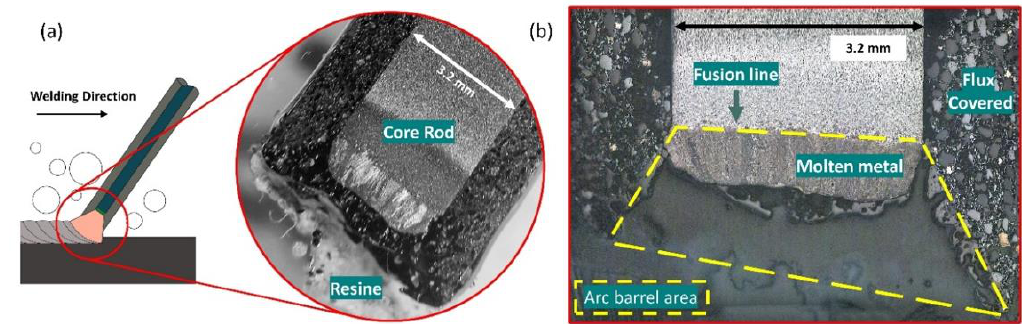
Figure 4. Scheme of the methodology for the measurement of arc barrel area in the tip of an electrode: ( a ) Arrangement of underwater wet welding process and a macrograph of the tip of an electrode; ( b ) image of the tip of an electrode showing the arc barrel area.